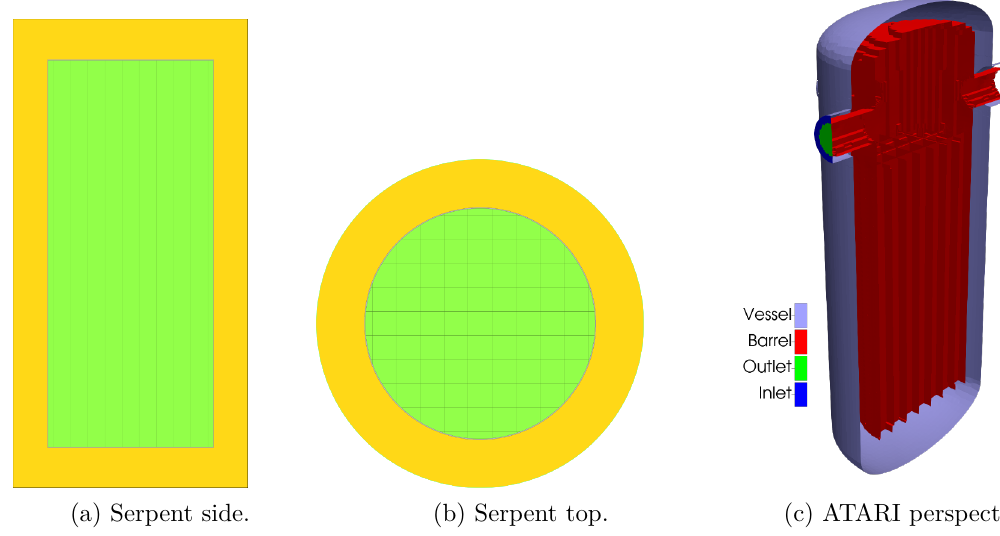
Figure 1: Core geometries with barrel and